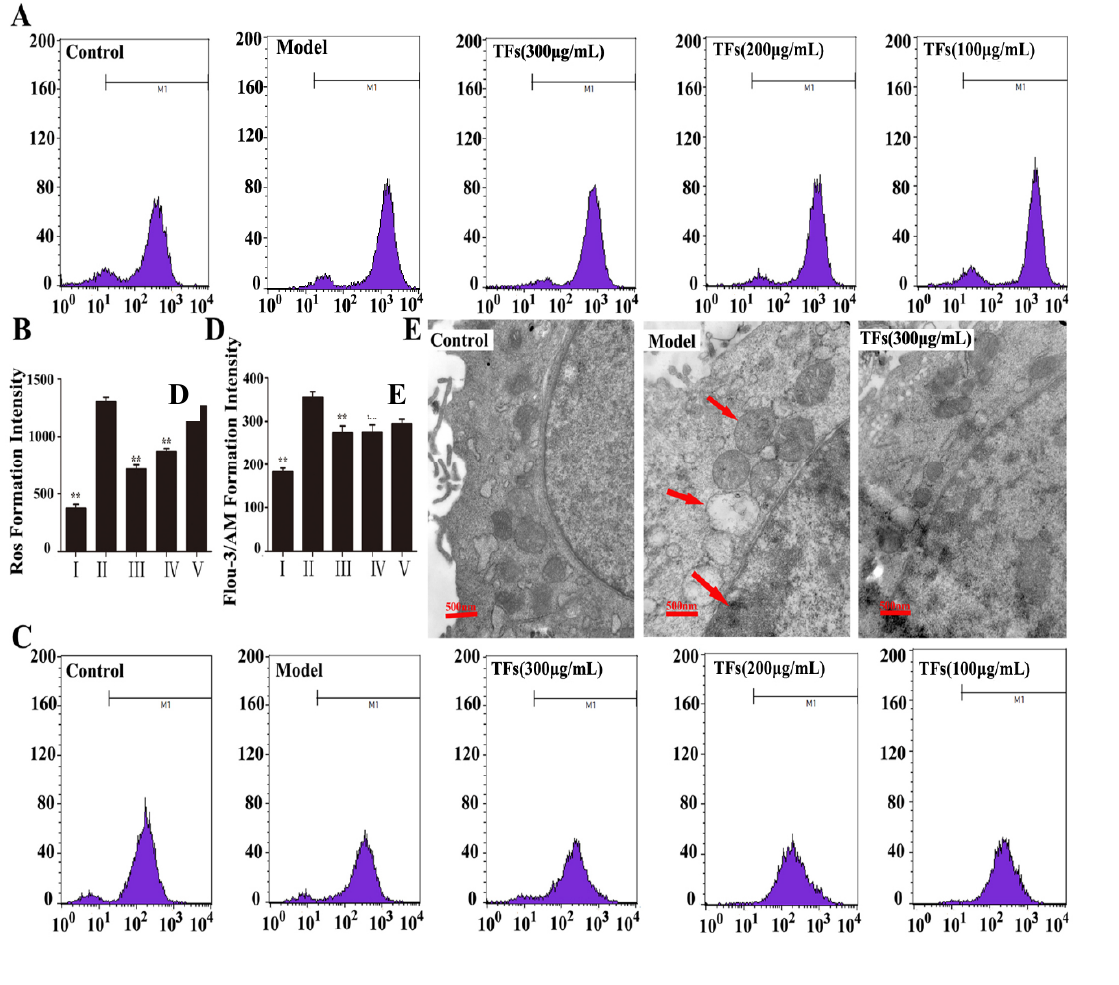
Figure 2. ROS generation detected by flow cytometry ( A , B ); The level of Ca 2+ detected by flow cytometry ( C , D ); Protective effect of the TFs on the ultra-structure of PC12 cells (40,000×, final magnification) ( E ). Data are presented as mean ± SD ( n = 5). * p < 0.05 and ** p < 0.01 compared with model group. The arrows pointed cytoplasmic vacuoles, chromatin condensation and mitochondrial swelling of the cells treated by H